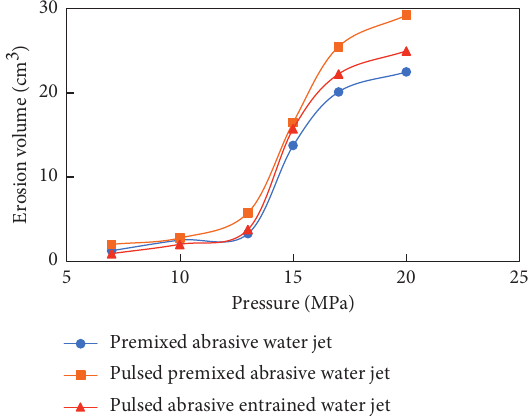
Figure 7: Erosion performance of the three kinds of abrasive water jets (when the jet standoff distance is 15 mm and the abrasive concentration is 1%).